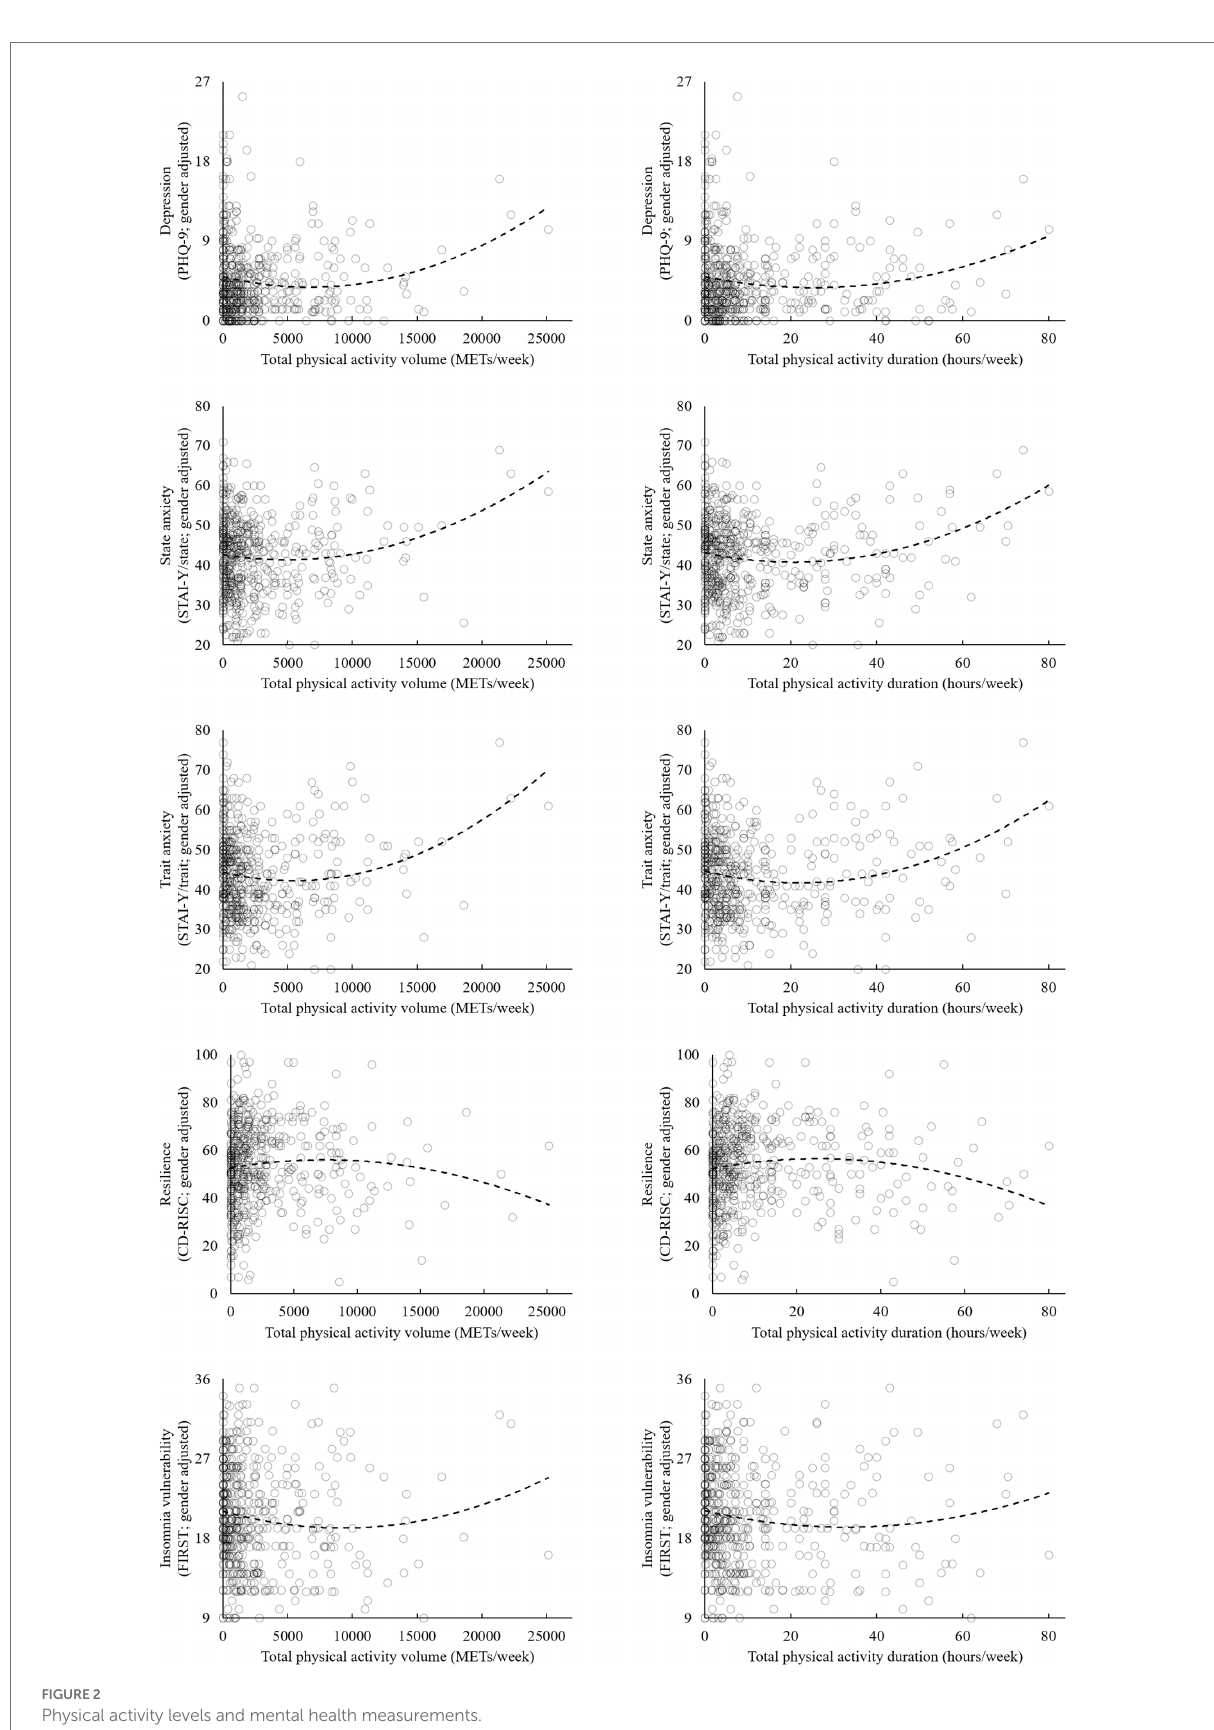
FIGURE 2 Physical activity levels and mental health